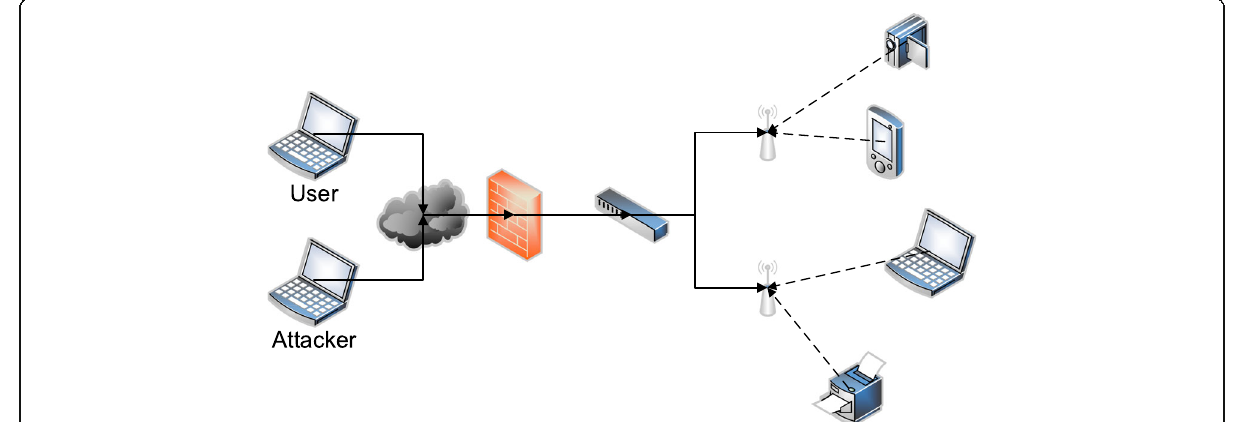
Fig. 3 The topological structure of the campus IoT